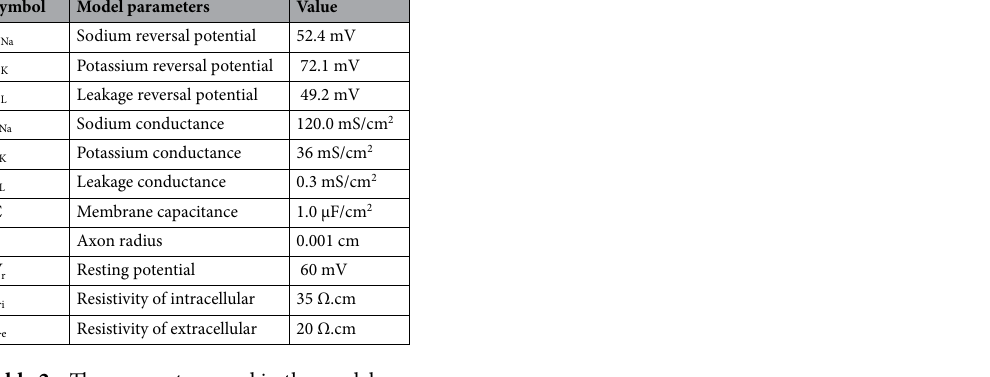
Table 2. The parameters used in the